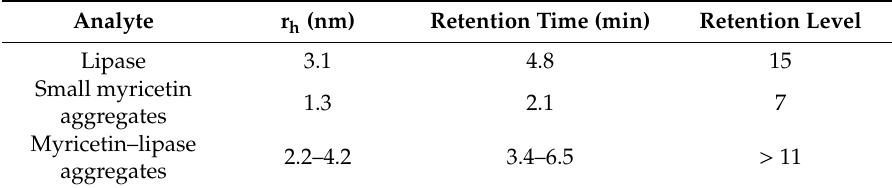
Table 2. Hydrodynamic